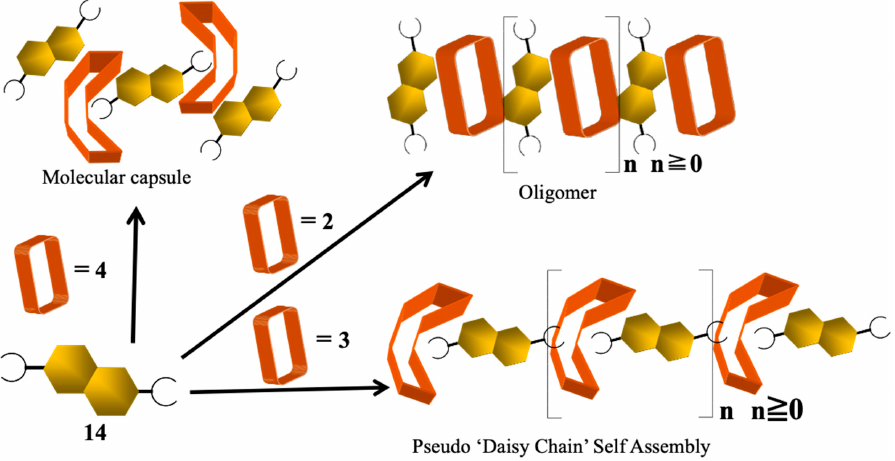
Figure 2. Cartoon representations of interlocked ensembles supported by the congeneric macrocycles 2 ‒ 4 in conjunction with 2,6-naphthalenedicarboxylate dianion. Modified from ref [43]. Copyright 2013 American Chemical Society.